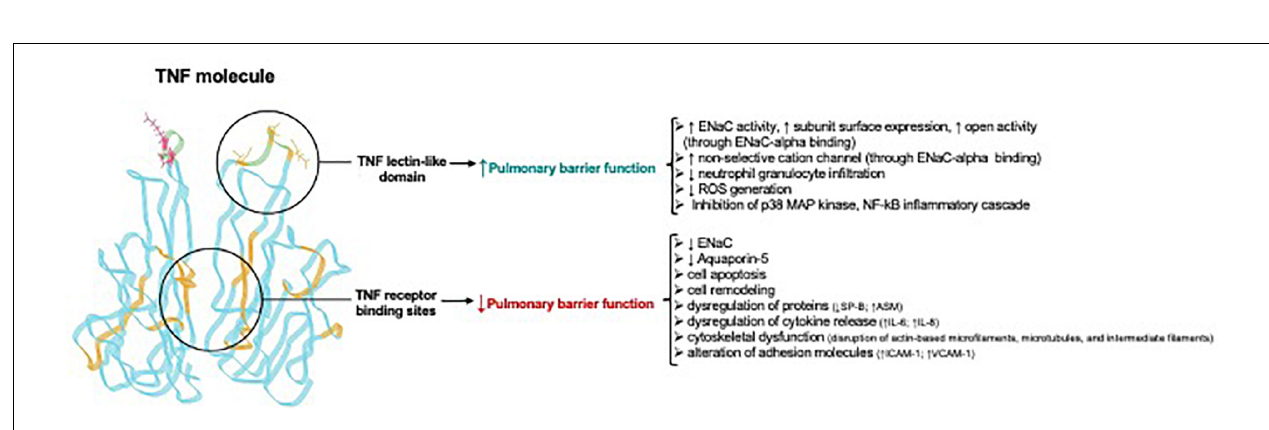
FIGURE 4 | Barrier-protective mechanism mediated by the TNF lectin-like domain in pneumolysin-treated human lung microvascular endothelial cells [adapted from Czikora et al. (2017)]. Pneumolysin forms pores in cholesterol-containing cell membranes, which increases Ca 2 + -influx (Lucas et al., 2012b), which mobilizes calmodulin to activate CaMKII, which in turn phosphorylates its substrate filamin A. Phosphorylated filamin A (Alli et al., 2015) then promotes stress fiber formation and enhances permeability of capillaries. Activation of ENaC by TIP peptide or of the non-selective cation channel, (NSC) either by TIP peptide (binding to ENaC- α ) or MitTx (binding to ASIC1a), inhibits pneumolysin-mediated CaMKII activation and subsequent hyperpermeability. ENaC activation moreover promotes PGE2 generation and eNOS activation, resulting in increased barrier-protective NO production. ASIC1a, acid-sensing ion channel 1a; CaMKII, Calcium/calmodulin- dependent protein kinase II; ENaC, epithelial sodium channel.